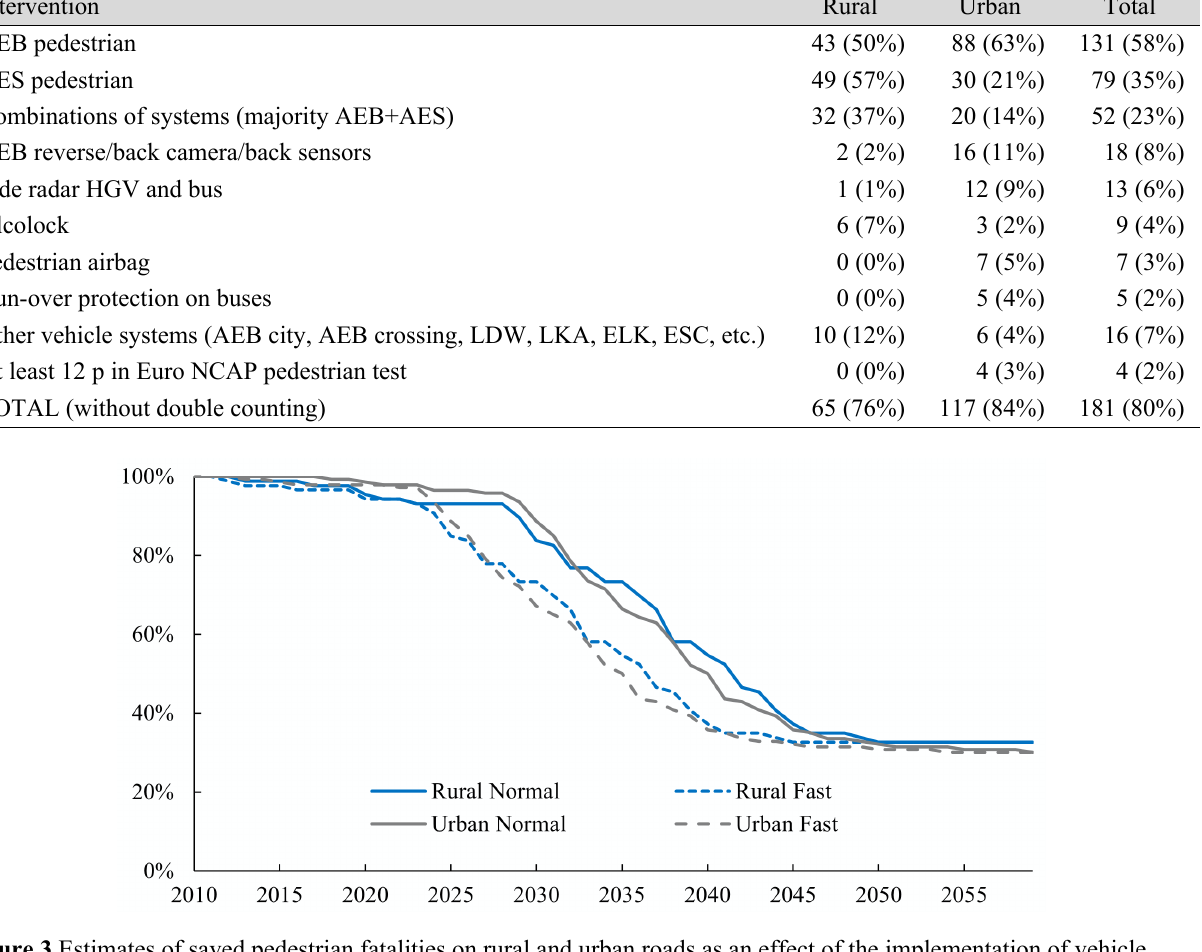
Figure 3 Estimates of saved pedestrian fatalities on rural and urban roads as an effect of the implementation of vehicle safety technologies listed in Appendix A. Dotted lines represent five-year faster implementation rates (denoted fast) and solid lines represent expected implementation rates (denoted